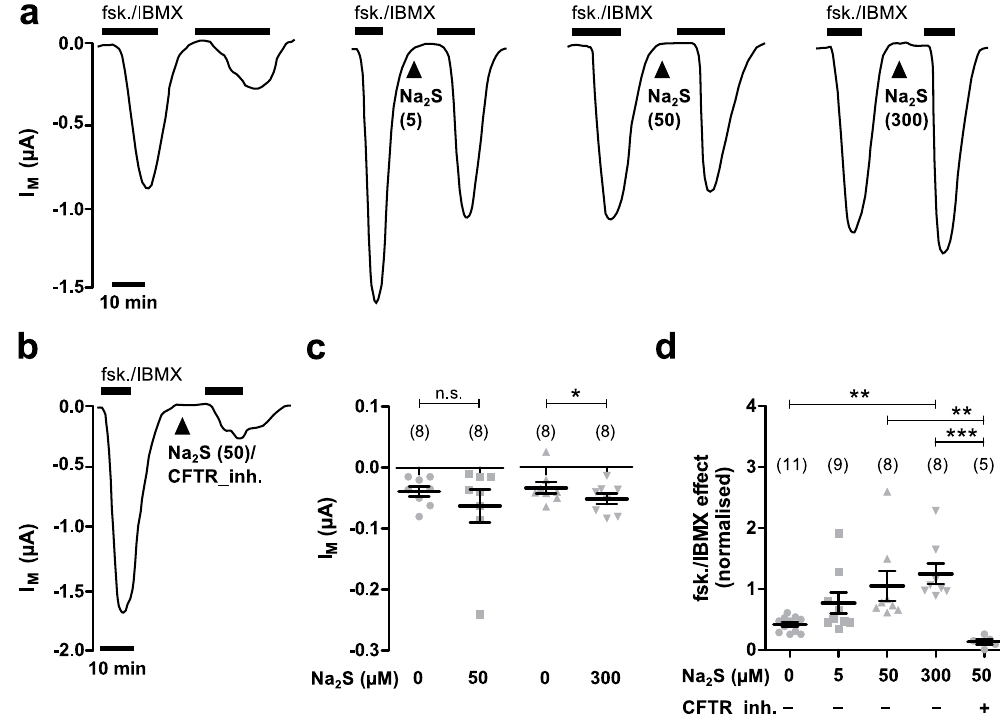
Figure 2. H 2 S potentiates the effect of forskolin and IBMX. ( a ) Representative current traces of TEVC recordings of CFTR-expressing oocytes. Transmembrane currents (I M ) were recorded and oocytes were exposed twice to forskolin (fsk., 5 µ M) and IBMX (100 µ M, black bars) without or with application of Na 2 S (arrowheads; concentration in µ M is indicated by numbers in parentheses) between the first and second stimulation with forskolin/IBMX. ( b) Representative current trace of a TEVC recording of a CFTR-expressing oocyte. Similar to experiments shown in panel a, oocytes were stimulated twice with forskolin/IBMX and Na 2 S (50 µ M) together with the CFTR inhibitor CFTR_inh172 (CFTR_inh., 25 µ M) between the first and second application of forskolin/IBMX. ( c ) Statistical analysis of data obtained from experiments as shown in panel a. Depicted are values of I M (peak values after drug application) from individual experiments (grey symbols) as well as means ± SEM, before and after application of Na 2 S ( * P ≤ 0.05, Student’s paired t-test). ( d ) Statistical analysis of data obtained from experiments as shown in panels a and b. Depicted are normalised values from individual experiments (grey symbols) as well as means ± SEM of forskolin (fsk.)/IBMX effects. This represents the ratio of the first and second current stimulated by forskolin/IBMX ( ** P ≤ 0.01, *** P ≤ 0.001, Kruskall-Wallis test followed by Dunn’s Multiple Comparison Test). Numbers of experiments (n) are indicated in